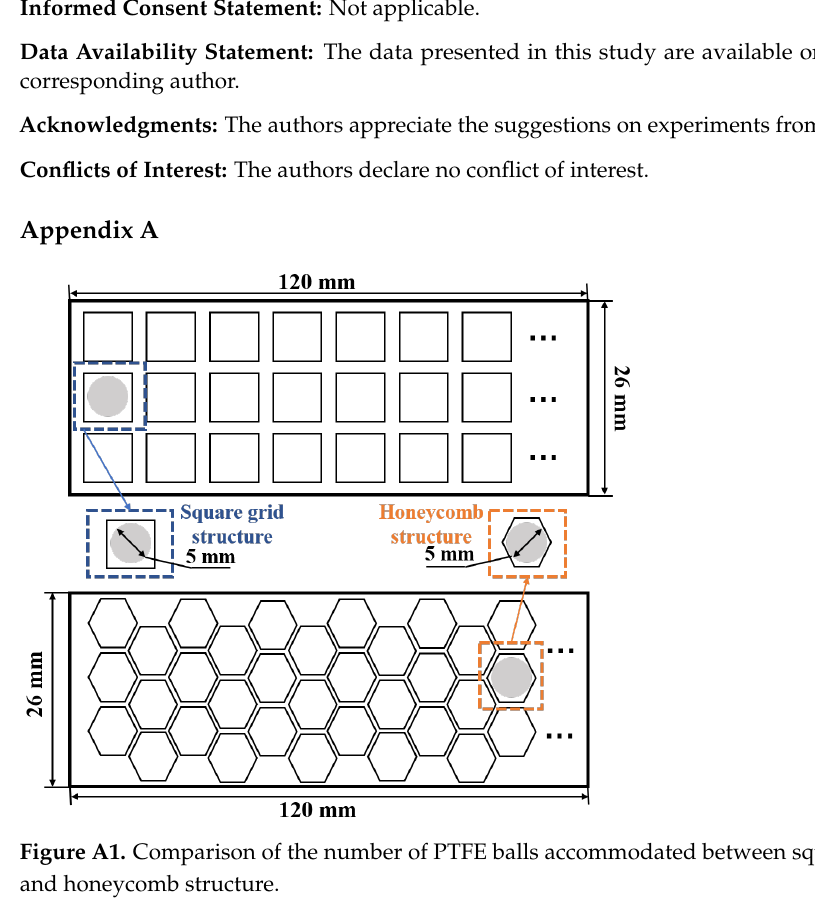
Figure A2. Experimental apparatus of the vibration characteristics of the SC-TENG.